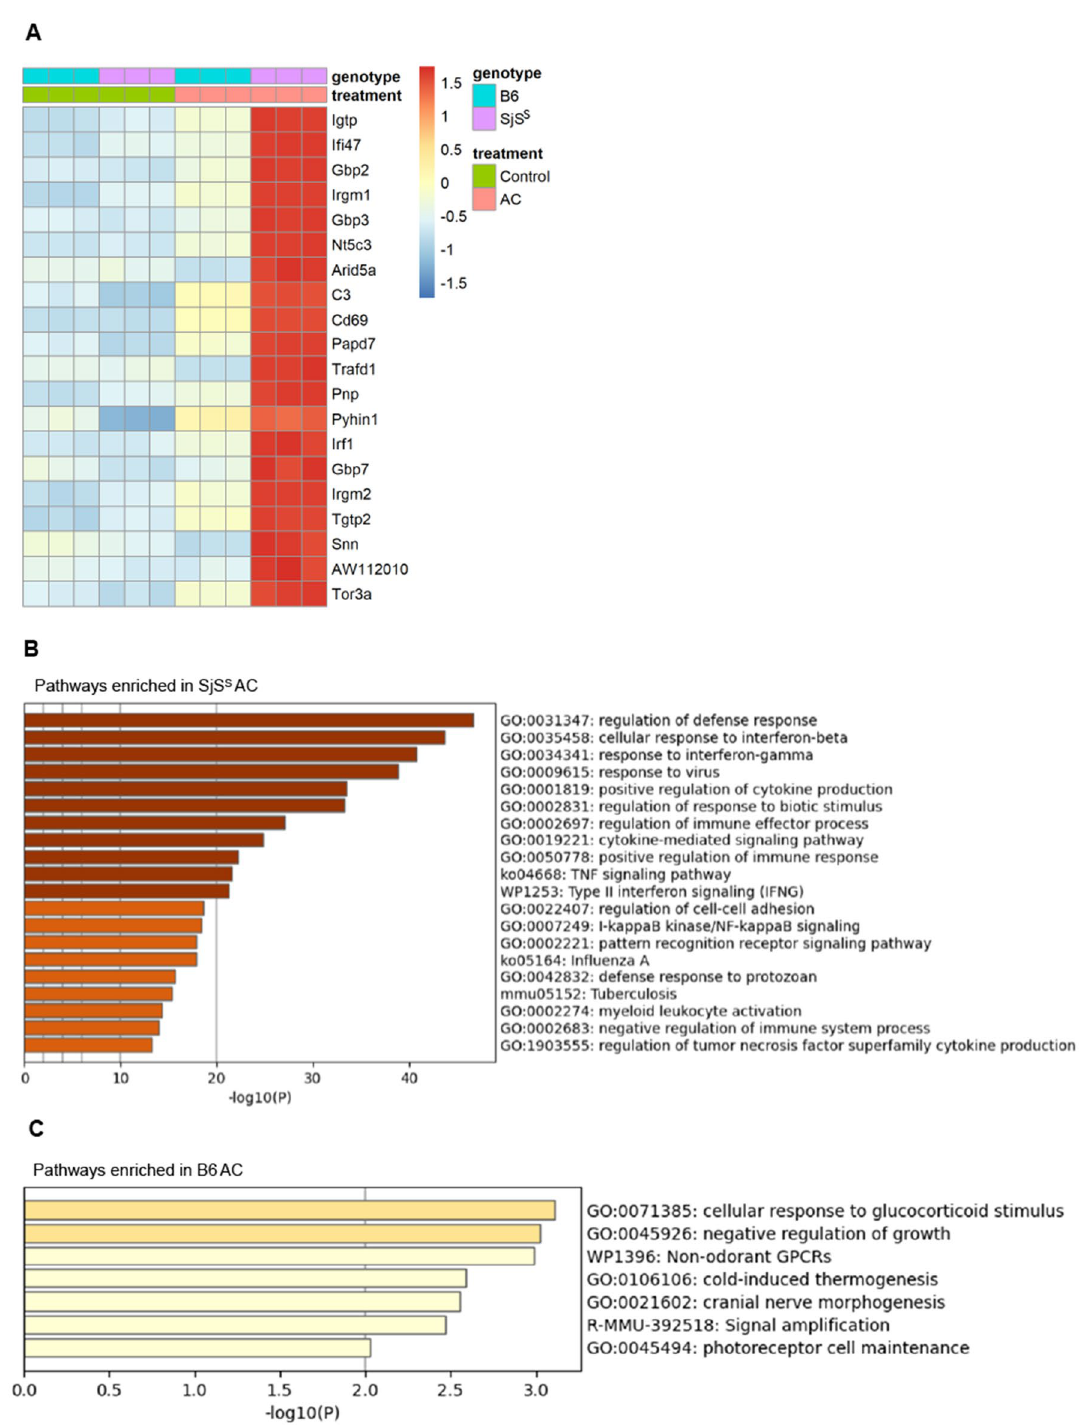
Figure 2. AC treated SjS S BMDMs display an inflammatory transcriptional response. ( A ) Heat map depicting top 20 most highly upregulated differentially expressed genes in the AC SjS S treatment condition with comparison to expression in other conditions (n = 3 mice per condition). ( B,C ) Enriched ontology clusters identified through Metascape revealed significant changes in gene pathways between SjS S ( B ) and B6 ( C ) BMDMs after AC